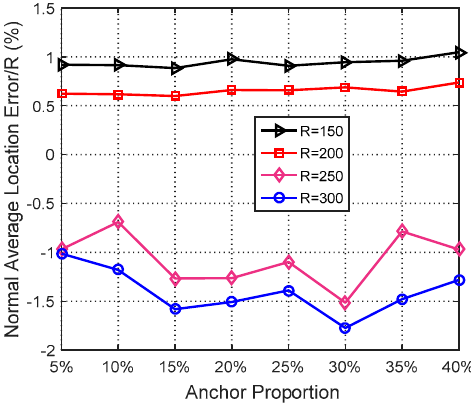
Figure 18. T he influence of R for WSN#2.